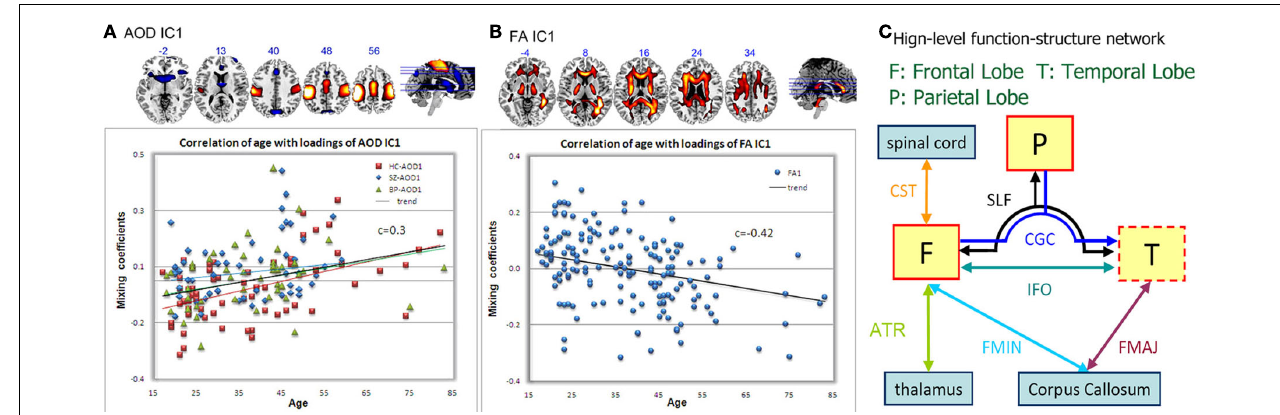
solid line frame indicates a major portion activation and the dotted line frame indicates that only small part of it is activated. Abbreviations are defined below, SLF, superior longitudinal fasciculus; CST, corticospinal tract; IFO, inferior fronto-occipital fasciculus; ILF, inferior longitudinal fasciculus; ATR, anterior thalamic radiation; CGC, cingulum; FMAJ, forceps major; FMIN, forceps